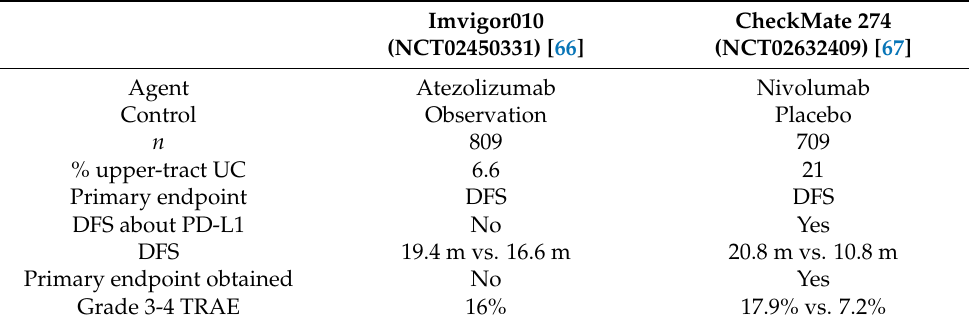
Table 5. Summary of phase 3 trials for adjuvant immunotherapy in